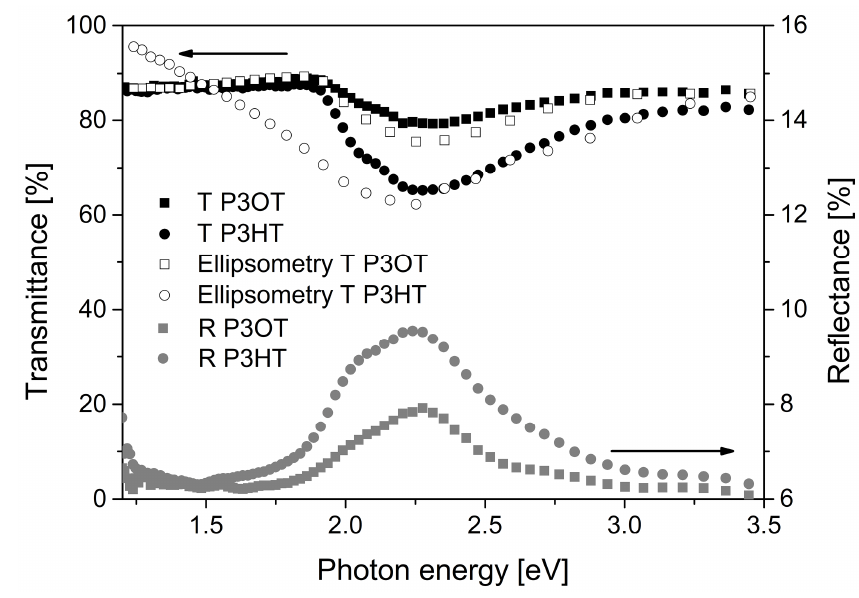
Figure 4. Spectral dependencies of transmission and reflectance of P3HT and P3OT.